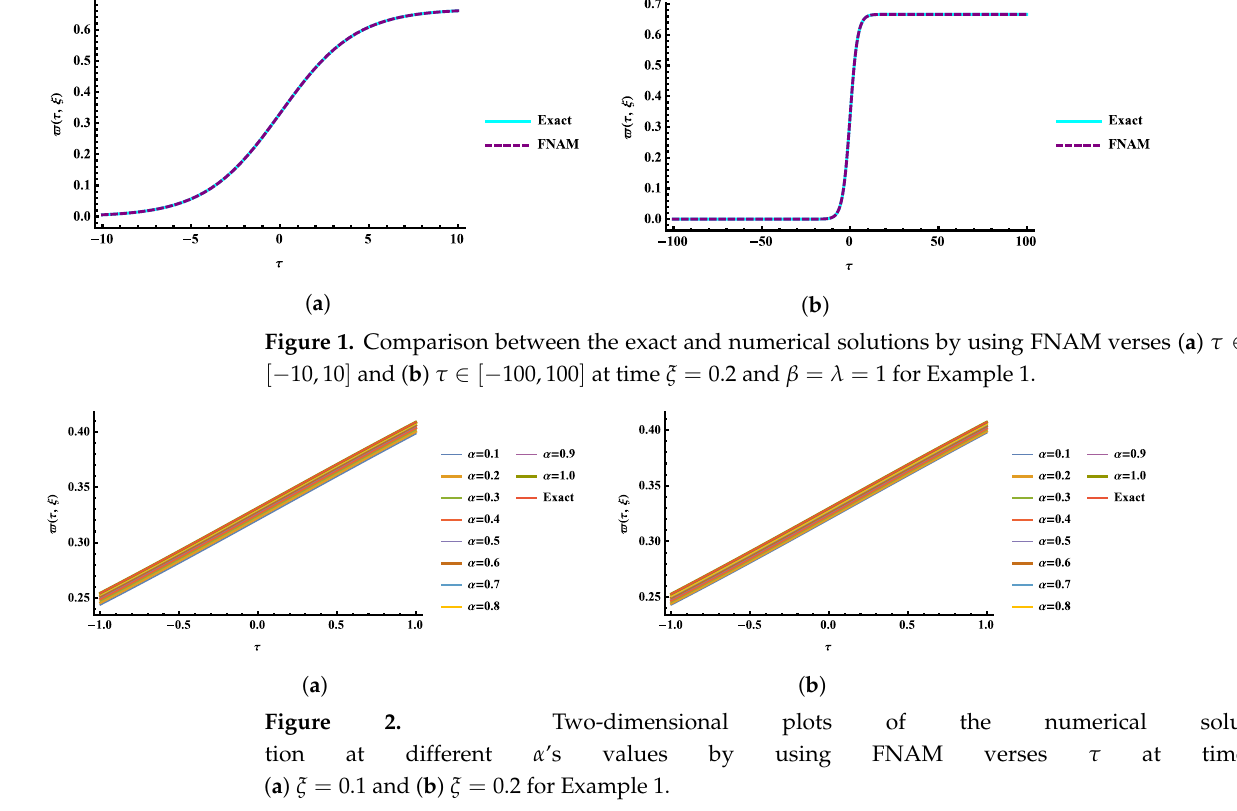
Figure 2. Two-dimensional plots of the numerical solu- tion at different α ’s values by using FNAM verses τ at time